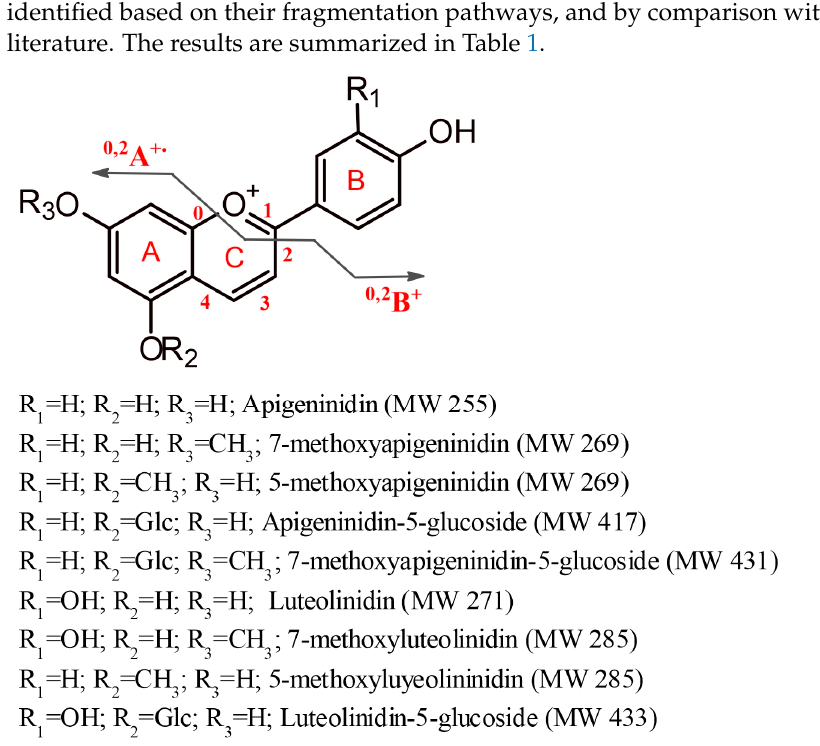
Figure 2. Total colour difference ( Δ E*) for the red dye extract non-encapsulated (NE) and extracts encapsulated with maltodextrin (MD) and Arabic gum (AG) obtained by freeze-drying (FD) and by spray-drying (SD) (mean ± SD). Different letters indicate significant differences ( p < 0.05) within the same ratio for carrier agents and the encapsulation process. on of 3-DXA by the two carrier agents. Relative to the processes used to obtain the microparticles, it was the freeze-drying process that allowed for better retention of the 3- DXA compounds.